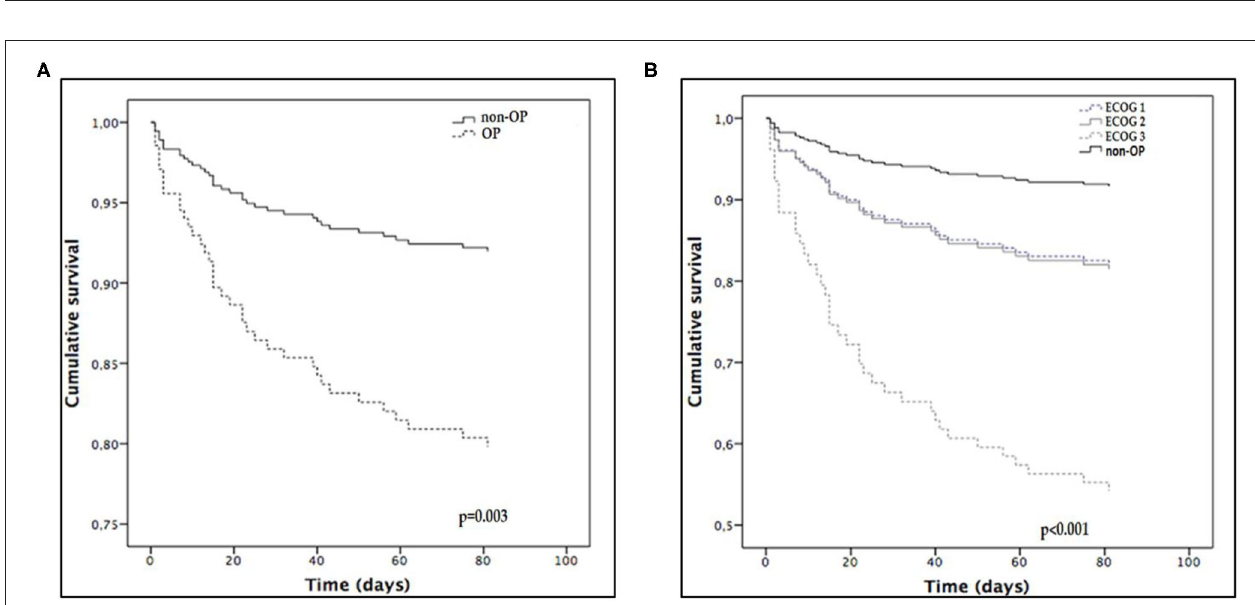
FIGURE 2 | Outcome distribution in oncological, non-oncological and all patients according to vasopressor need with hyperlactatemia ( > 2 mmol/L), vasopressor need without hyperlactatemia, and hyperlactatemia ( > 2 mmol/L) without vasopressor need.